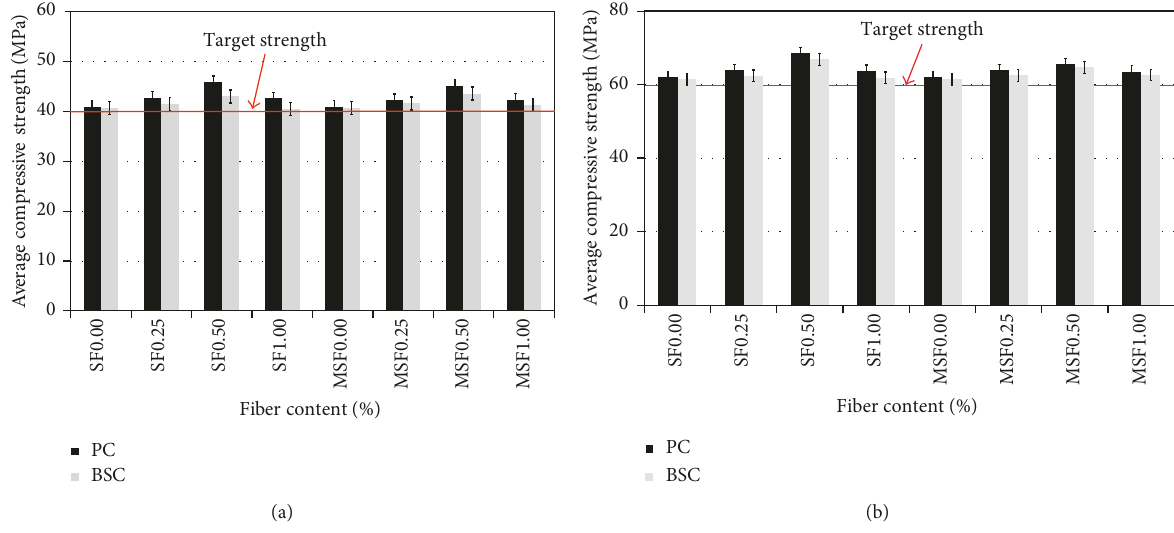
Figure 7: Compressive strength with fiber volume fraction. (a) Target strength 40MPa. (b) Target strength 60MPa.